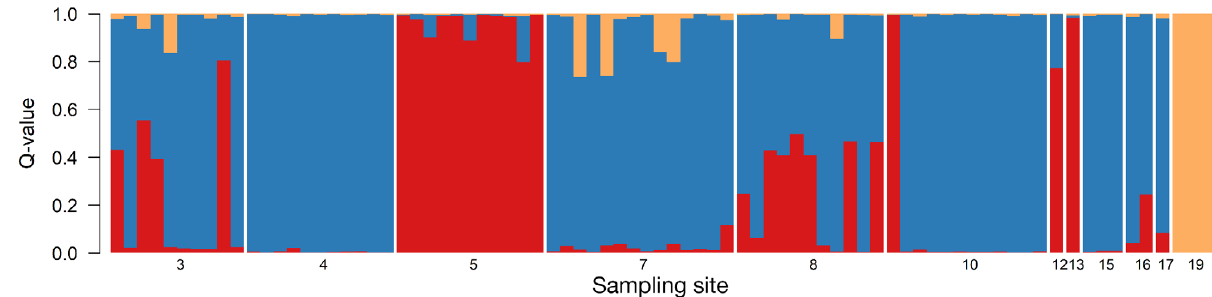
Fig. 2. Genetic structure of free-living Atlantic salmon using STRUCTURE K = 3. Estimated genetic structure of 80 individuals distributed by sampling site, revealed by 272 single nucleotide polymorphism markers for K = 3. The most prominent cluster is represented in blue, followed by red and light brown. Each individual is represented by a single vertical line with the esti- mated individual proportions of cluster membership